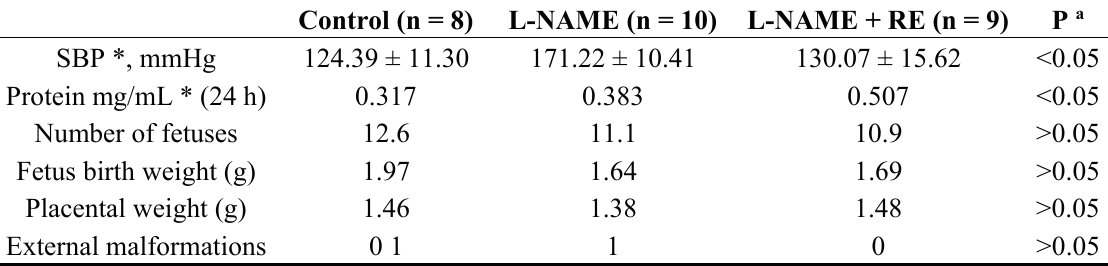
Table 1. Parameters of pregnant rats after each